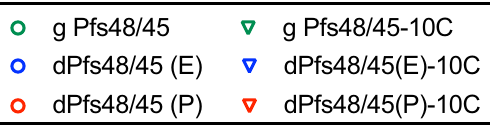
Figure 8. Correlation between ELISA units and SMFA activity. Anti-dPfs48/45 (E) ELISA units (on a square root scale, x-axis) and the associated the best estimated %TRA value from two feeds (on the left side of the y-axis) of each test IgG are shown. The ratio of mean oocyst (mean oocyst density in control divided by mean in test) is plotted on a log scale (LMR, right side of